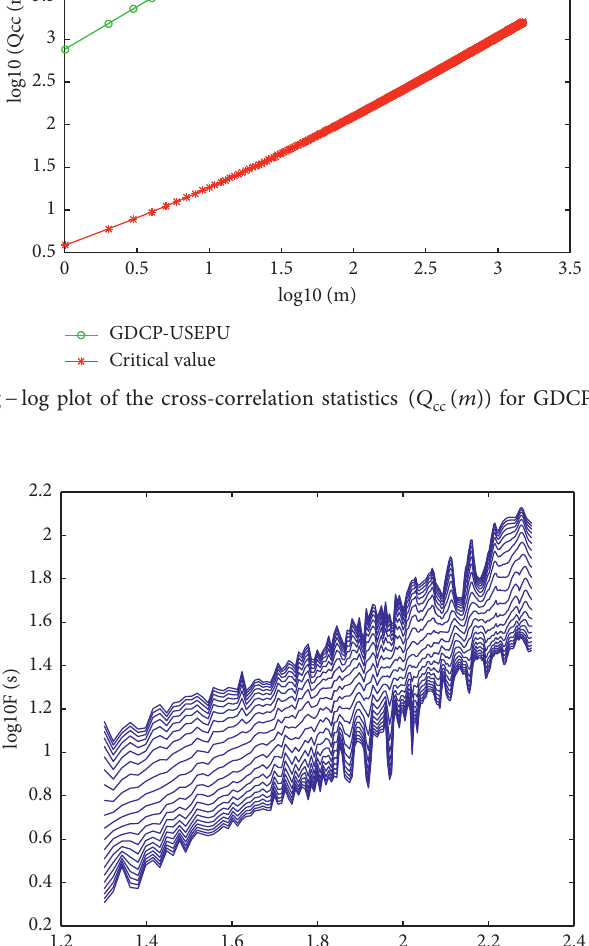
Figure 4: Log − log plot of F ( s ) versus s for GDCP and